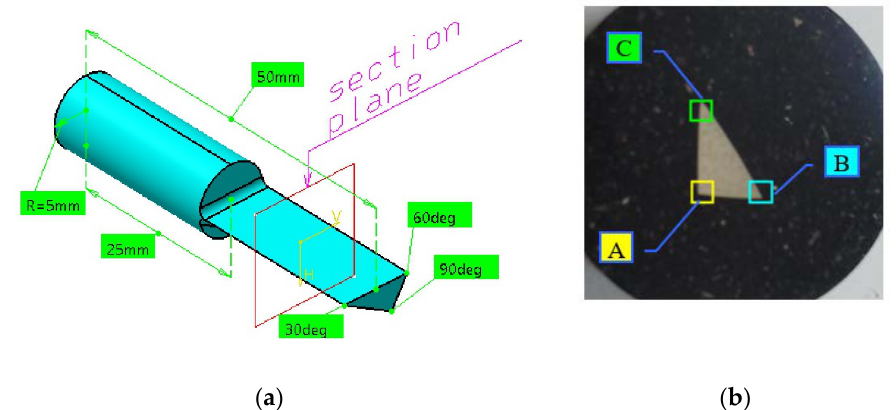
Figure 4. Sequence for obtaining the micrograph samples: ( a ) sample used for experiment with sectioning plane and ( b ) embedded sample.